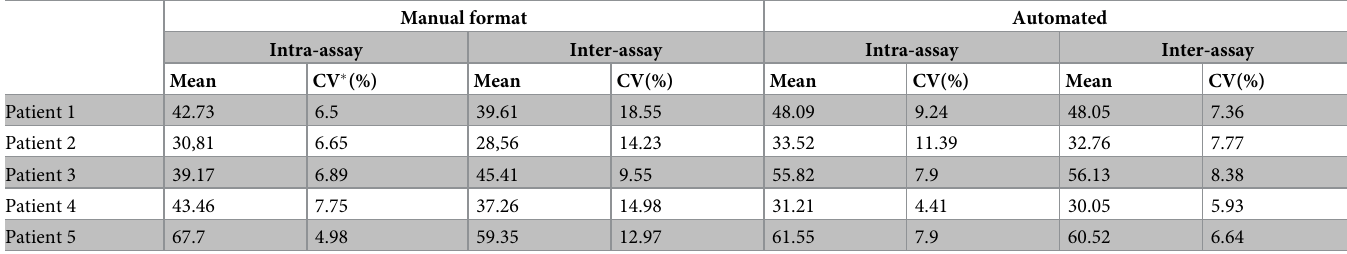
Fig 4. The impact of higher concentrations of FIX and FX on determination of emicizumab plasma level. FVIII-deficient plasma was spiked with FIX (A) or FX (B) to reach 100%, 150% and 200% of normal plasma levels in molarity. Then samples were spiked with emicizumab ( ● indicates 100 μ g/ml emicizumab; ■ 10 μ g/ml emicizumab and ▲ without emicizumab). A dilution factor of 1:20 of each plasma samples was incubated with FIXa (40 nM) and FX (150 nM) for 5 min followed by addition of S-2765 substrate (500 nM final concentration). Substrate conversion was measured at 405 nm using microtiter plate reader. Data were collected in triplicate in a kinetic measurement of 5 min and expressed as the means ± s.d. https://doi.org/10.1371/journal.pone.0271330.g004 curve is shown in S2 Fig. The LoD and LLoQ of the manual assay, which were defined as three and nine times the standard deviation (SD) above the mean of six replicates of the blank were found to be 0.63 μ g/ml and 1.96 μ g/ml, respectively. Using the BCS XP system for assay auto- mation however, increased the LoD and LLoQ to 6.33 μ g/ml and 9.53 μ g/ml, respectively (see S2 Fig for standard curve). The intra-assay and inter-assay coefficient of variations (CVs) were calculated using citrated plasma obtained from five patients diagnosed with severe HA (FVIII activity < 2%) and under treatment with emicizumab. For the manual method, the data showed intra-assay CVs that ranged from 4.98% to 7.75%, while inter-assay CVs varied between 9.55% and 18.55%. Performing the assay on the automated coagulometer analyzer demonstrated intra- and inter-assay CVs of 4.41% to 11.95% and 5.93% to 8.38%, respectively (Table 1). Mean recoveries for low (20 μ g/ml), medium (40 μ g/ml) and high (80 μ g/ml) emici- zumab levels were 91.5%, 90% and 95.8%, respectively (Table 2). Chromogenic assay (emi-tenase) vs. mOSC: Comparison of assay results To assess the agreement between the mOSC and the newly developed chromogenic emicizu- mab assay (emi-tenase), correlation- as well as Bland-Altman analysis was applied [27]. Briefly, Table 1. Intra-assay and inter-assay